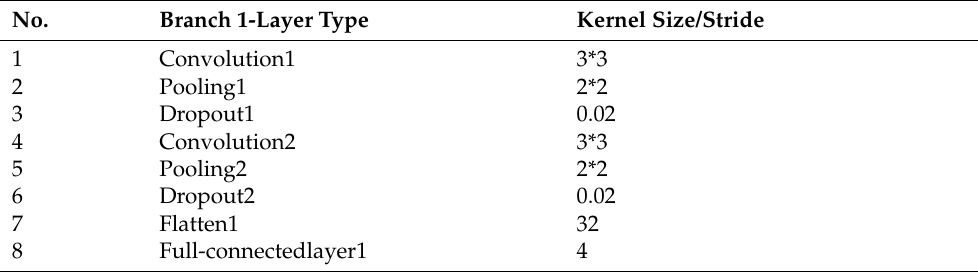
Figure 3. Construction of the generative model.